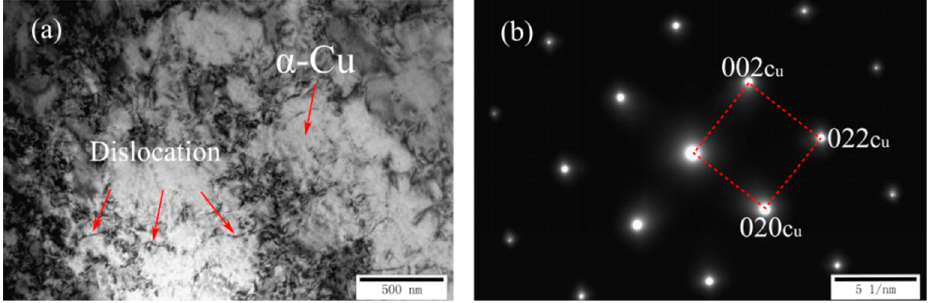
Figure 2. Microstructures of as-cast Cu-7Ni-1Fe-1Mn alloy: ( a ) TEM image; and ( b ) the corresponding SADP of ( a ).